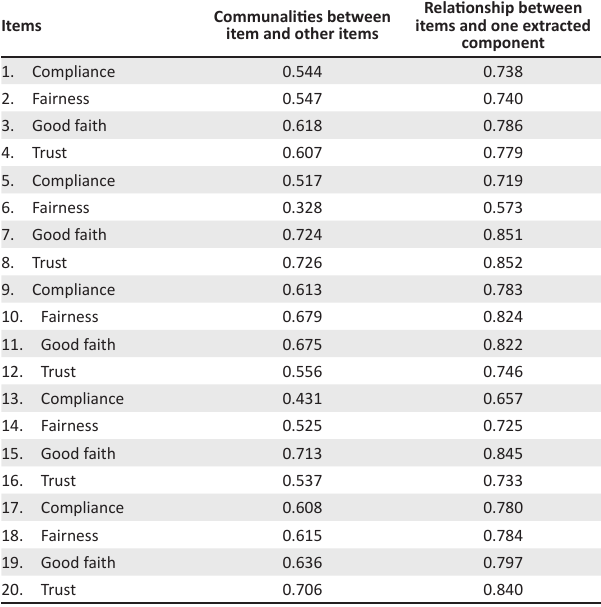
TABLE 3-A1: Principal components analysis communalities and component